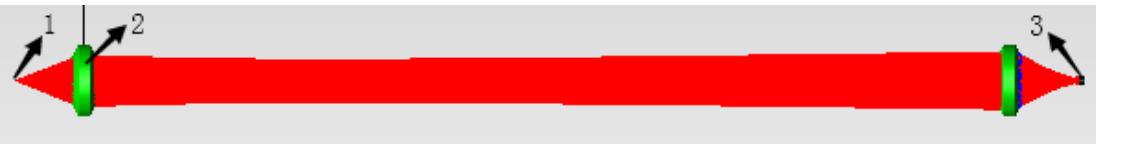
Figure 3. ( a ) Mathematical model of cross-section and ( b ) three-dimensional spiral structure of the pentahedron gas-cell.